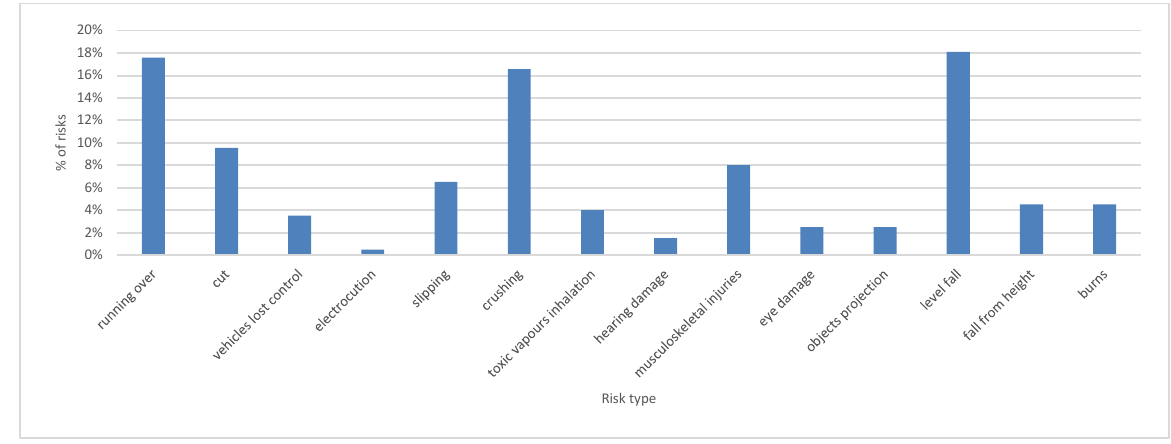
Figure 10. Risk influence on the most dangerous activities